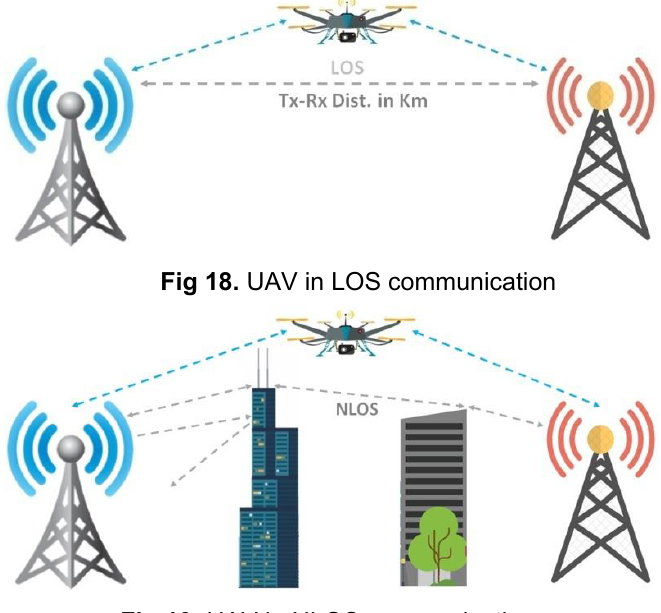
Fig 19. UAV in NLOS